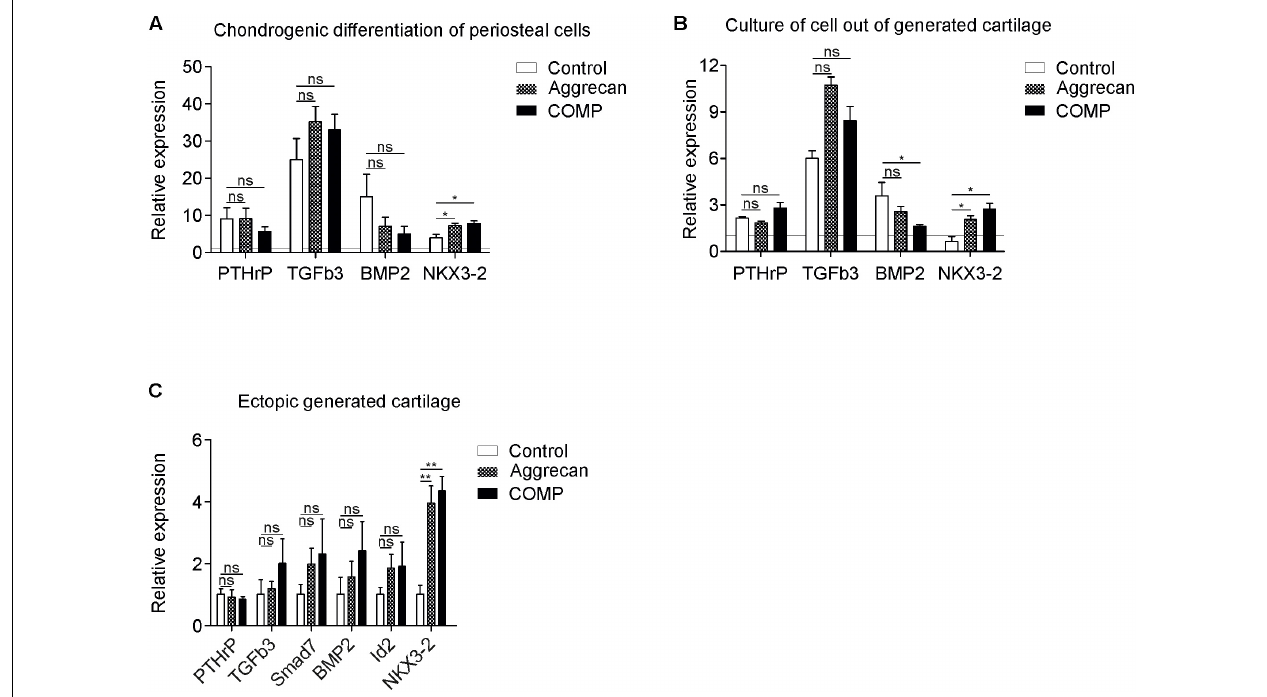
FIGURE 5 | Increased NKX3-2 mRNA expression in COMP and Aggrecan generated cartilage in vitro and in vivo . (A) Expression of PTHrP, TGFb3, BMP2, and NKX3-2 was determined by RT-qPCR, normalized for 28S rRNA expression and set relative to baseline ( t = 0) values (indicated by horizontal line) in samples from Figure 1 (chondrogenic differentiation of periosteal cells). (B) Expression of PTHrP, TGFb3, BMP2, and NKX3-2 was determined by RT-qPCR, normalized for 28S rRNA expression and set relative to baseline ( t = 0) values (indicated by horizontal line) in samples from Figure 2 (redifferentiation of cells isolated from ectopically generated cartilage). (C) Expression of PTHrP, TGFb3, Smad7, BMP2, Id2, NKX3-2 was determined by RT-qPCR and normalized for 28S rRNA expression in samples from Figure 4 (ectopically generated cartilage in vivo ). White bars represent the control condition, dotted bars the condition supplemented with Aggrecan and the black bars the condition supplemented with COMP. In graphs, error bars represent mean ± SEM. Statistically significant differences ( p < 0.05) are shown by an *, ** = p < 0.01, ns = not